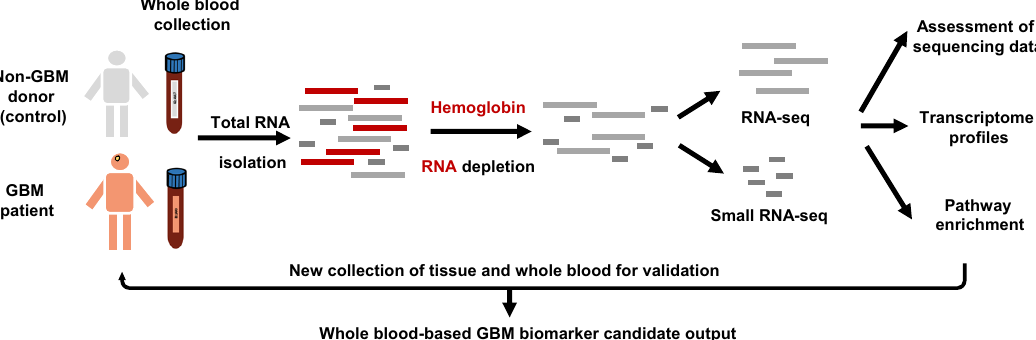
Fig. 1 Schematic overview of the WBGR work fl ow. We performed globin reduction on RNA isolated from 22 individuals and RNA-seq on 28 RNA samples derived from them. We assessed the sequencing data from the pre-GR group and post-GR group and performed differential transcriptomic analysis on all post-GR samples. We then conducted functional enrichment analysis and identi fi ed potential GBM-associated transcriptomic